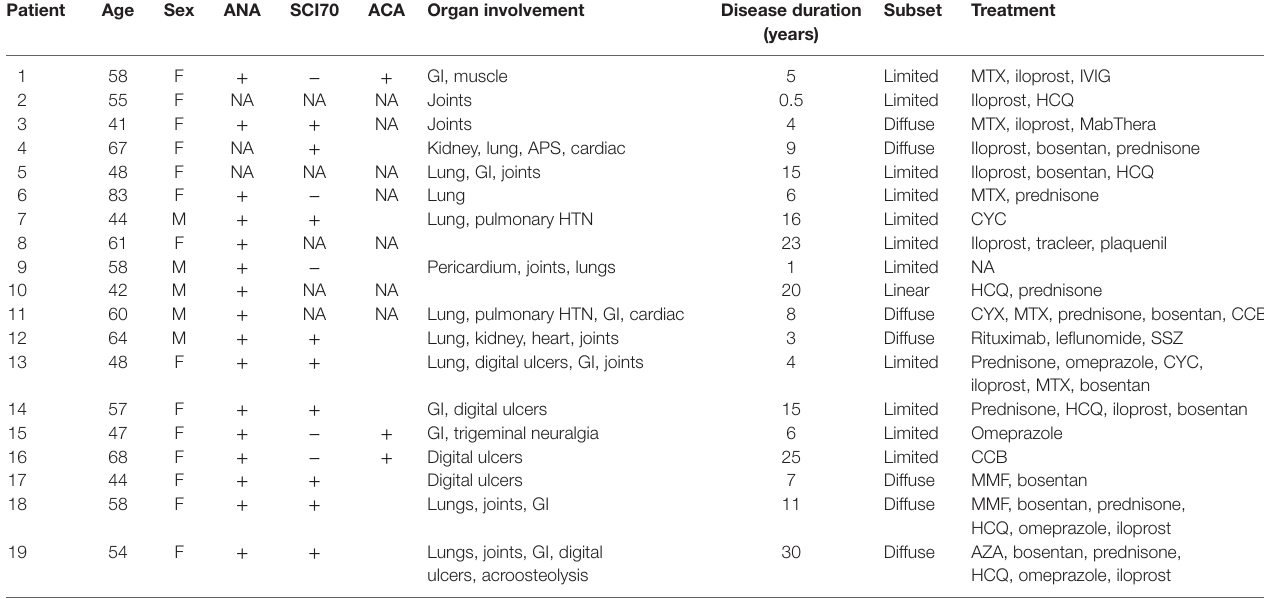
TaBle 1 | Clinical characteristics of systemic sclerosis patients.